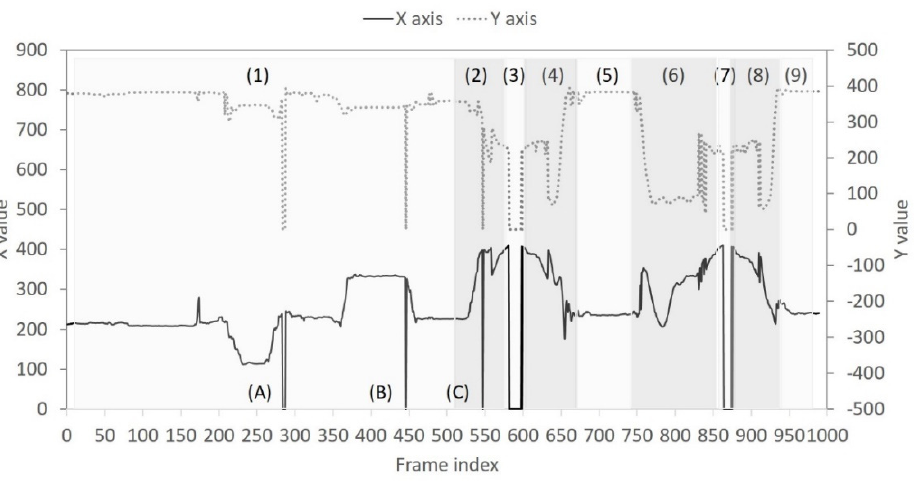
Figure 6. Real − time trace of XY coordinates for the bounding box from the horizontal low angle: numbers (1)~(9) stand for different statuses; letters (A)~(C) represent detection failure events.